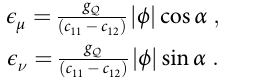
; T ; T , T T < T , and T > T . The order Q O O < Q Q O and T , Q O